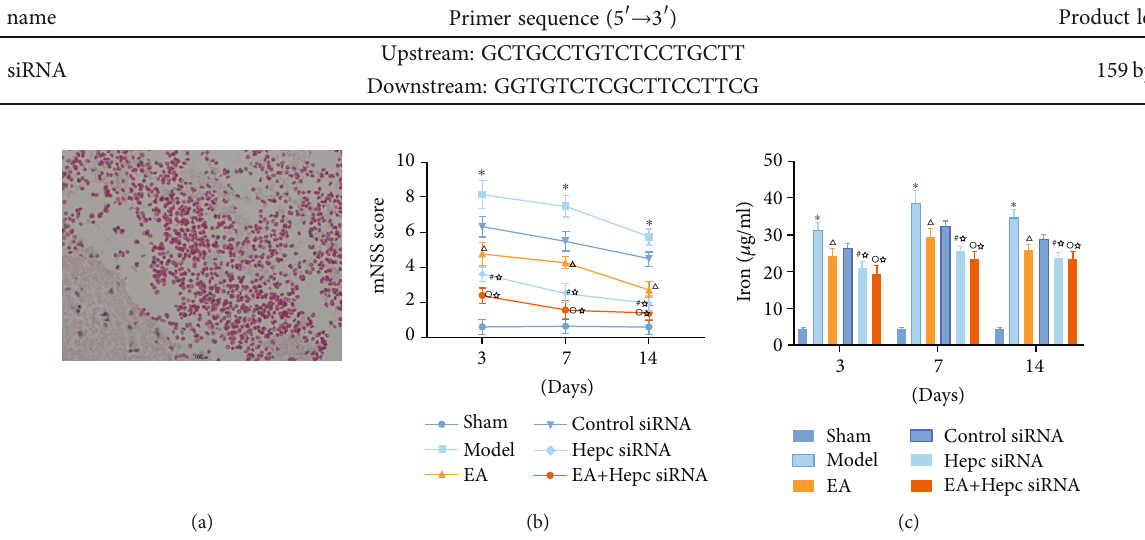
Figure 2: mNSS scores and total iron content of rats in each group. Note: ∗ P < 0 : 01 vs. sham group, △ P < 0 : 01 vs. model group; ☆ P < 0 : 01 vs. EA group, # P < 0 : 01 vs. control siRNA group, and ○ P < 0 : 01 vs. Hepc siRNA